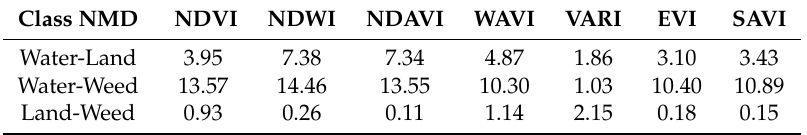
Table 4. Normalized mean distances (NMDs) between the classes for each vegetation